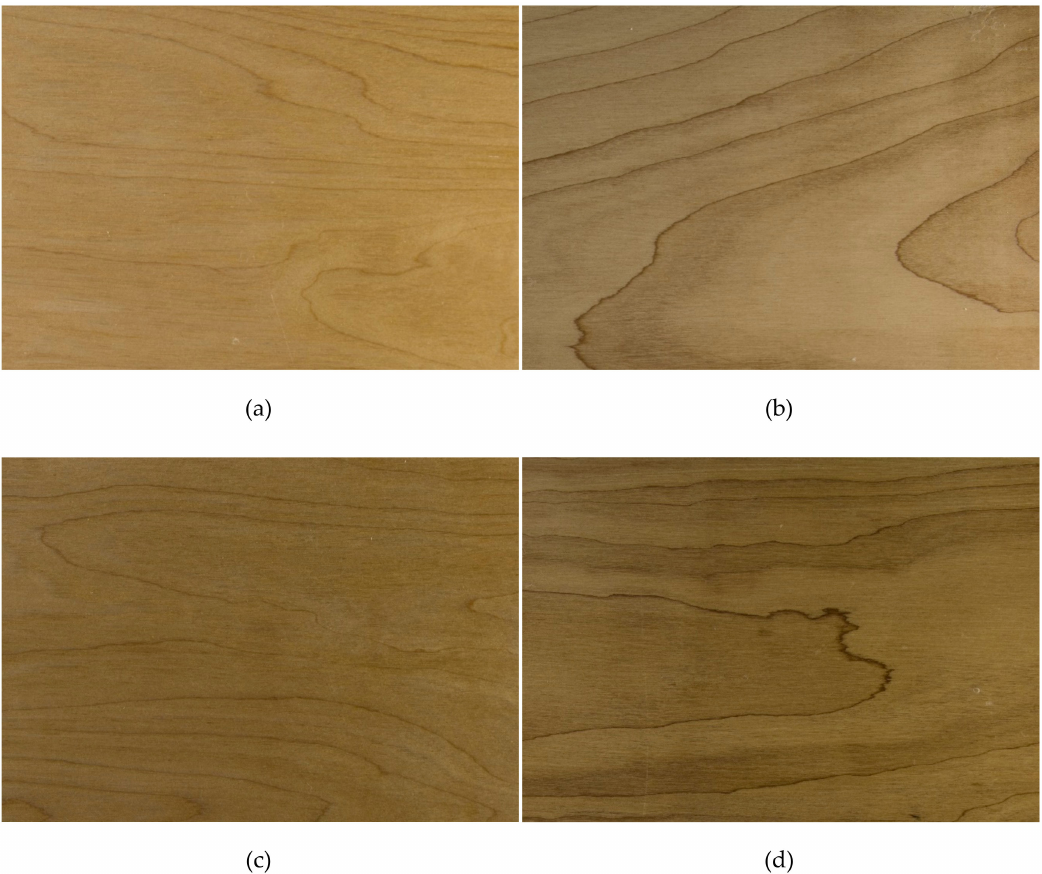
Figure 19. Photos of the sliced and peeled veneer. Sliced veneer - treated at 190 ◦ C / 1 h ( a ), peeled veneer—treated at 190 ◦ C / 1 h ( b ), sliced veneer—treated at 200 ◦ C / 1 h ( c ), peeled veneer —treated at 200 ◦ C / 1 h ( d